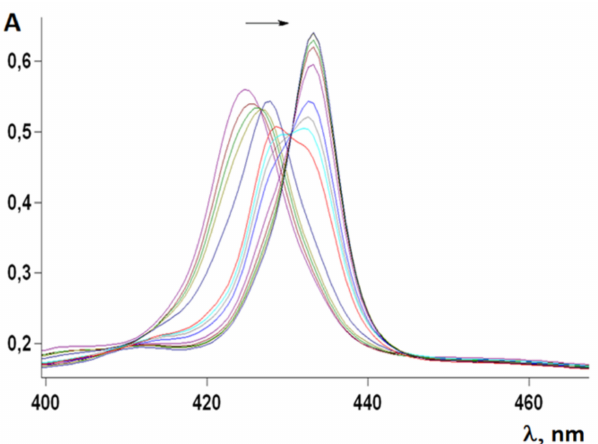
Figure 21. Changes in the absorption spectra ( a ) and titration curves ( b ) of porphyrinate 84 with DABCO in toluene, 20 ◦ C. [ 84 ] = 1.0 × 10 − 6 M, [DABCO] = 0 ÷ 2.0 × 10 − 4